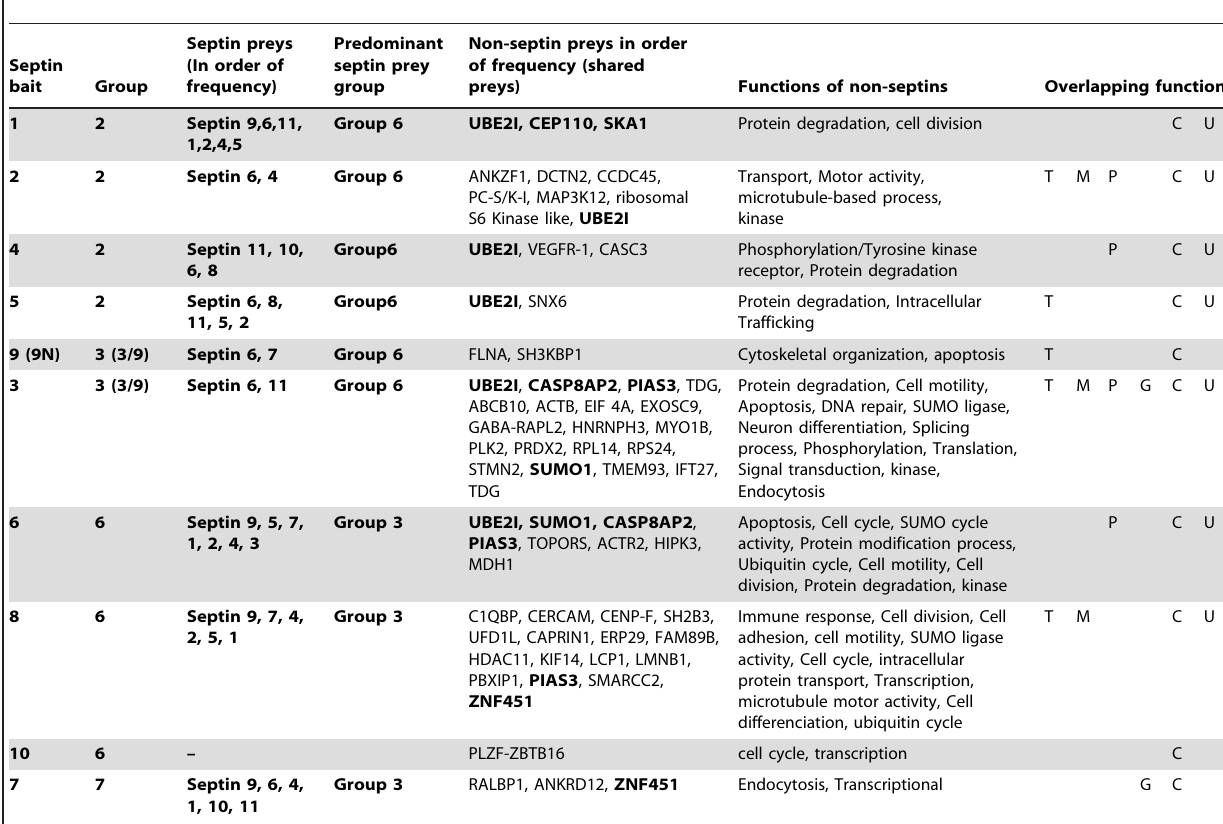
Table 2. Summary table of all septin interacting proteins identified and their functional assignments.